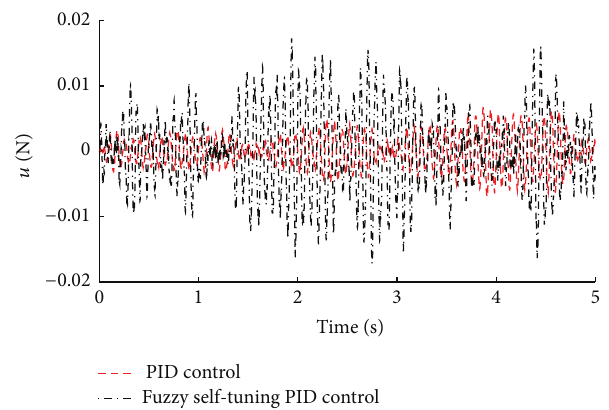
Figure 9: The control forces with white noise disturbance.